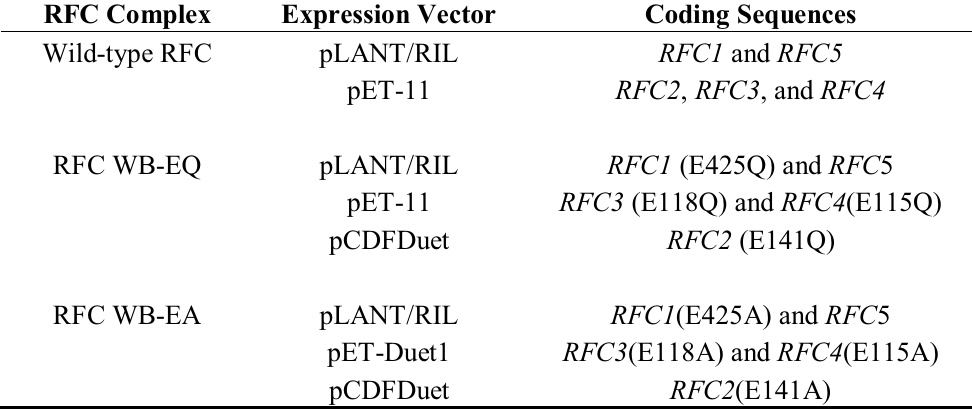
Table 1. Expression vectors used to produce wild-type RFC and Walker B